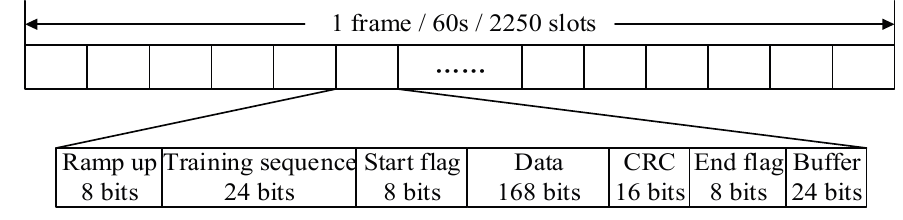
Figure 2. Structure of AIS